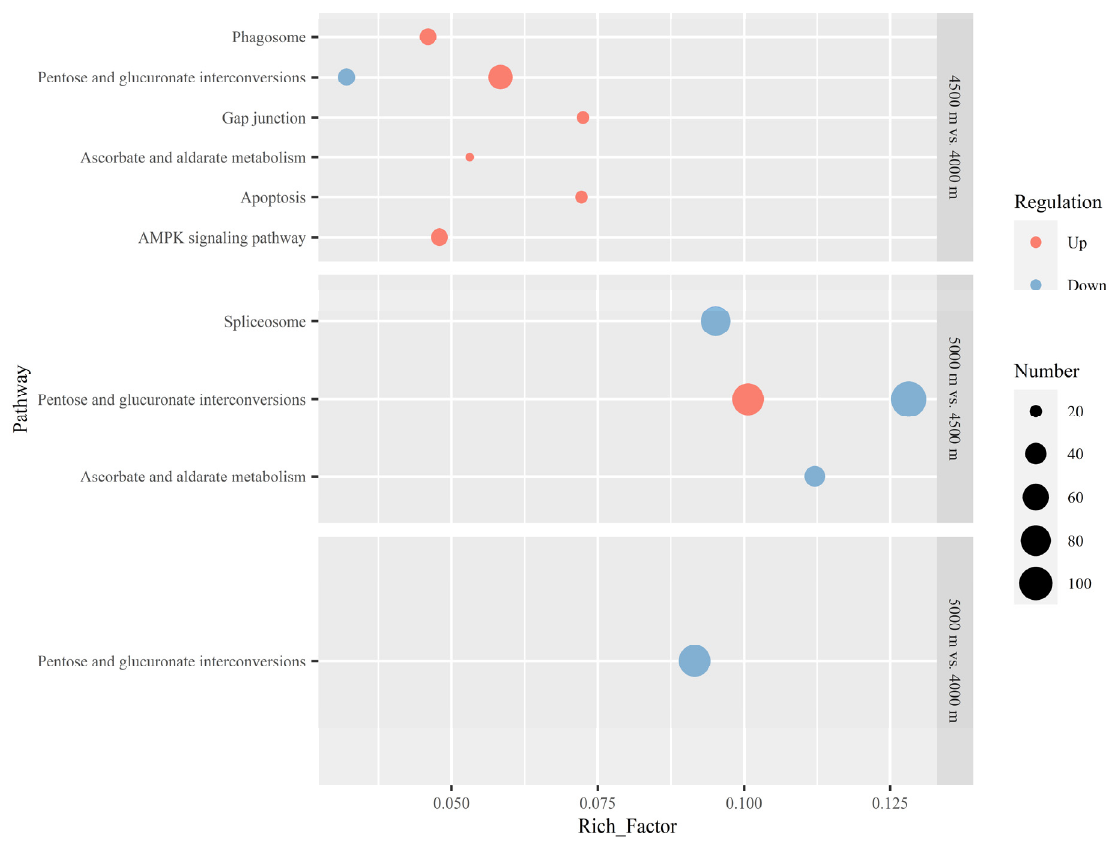
Figure 3. Pathways enriched by differentially expressed genes (DEGs) of Bombus waltoni in com- parisons between different altitudes. All pathways with an adjusted p -value lower than 0.05 are shown for each comparison. No significant up-regulated DEGs were detected in the 5000 m vs. 4000 m comparison; therefore, it is not included in the figure. “Number” denotes the number of DEGs enriched in the pathway. The pathways with red points are enriched by up-regulated DEGs, while those with blue points are enriched by down-regulated DEGs.